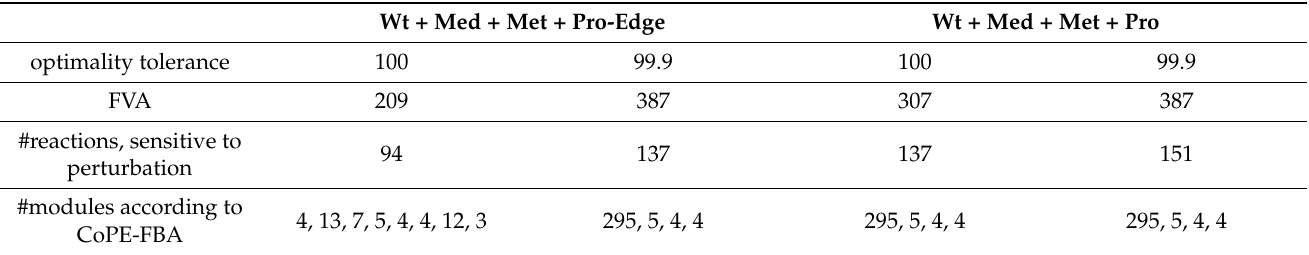
Table 3. Number of variable reactions according to FVA (with the interval size larger than 10 − 6 ), number of sensitive reactions according to the solution space inspection procedure (perturbation analysis), and the number of reactions in existing modules in each model (CoPE-FBA). All three methods were used with two optimality tolerance values (100% and 99.9%) and the respective results were